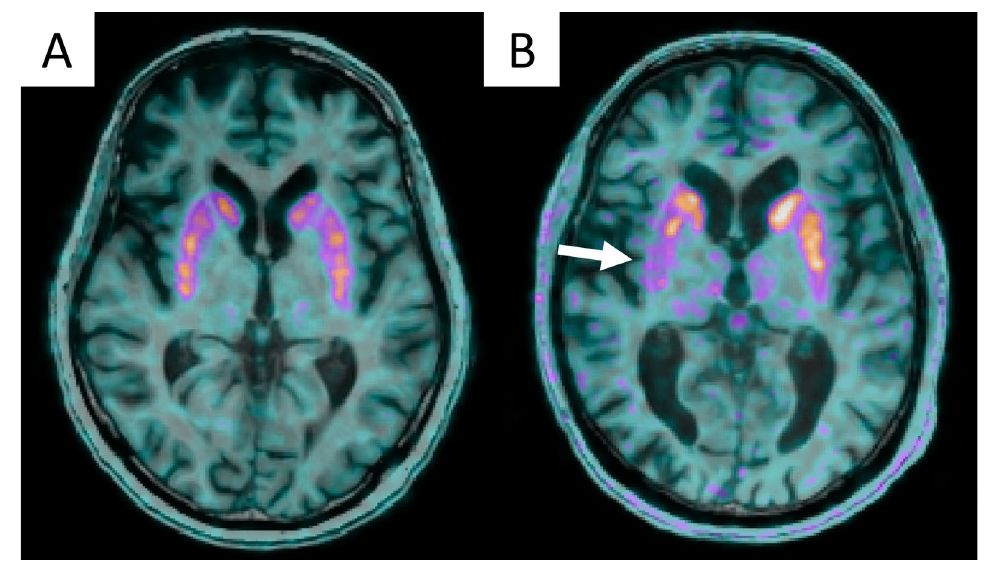
Fig. 4 Visual analyses of 18 F-DOPA PET/MRI according to the international guidelines [11]. A This IPD patient, visually considered normal. The clinical follow-up and had symptoms relief after L-DOPA therapeutic test classified him as FN. Only min SUVr was below the 95% confidence interval estimated from controls. B This IPD presented unilateral right posterior putamen (white arrow) pre-synaptic dopamine denervation and global striatal 18 F-DOPA decrease with faintly increased background unspecific activity. PET right putamen dopamine denervation was confirmed with symptoms relief after L-DOPA therapeutic